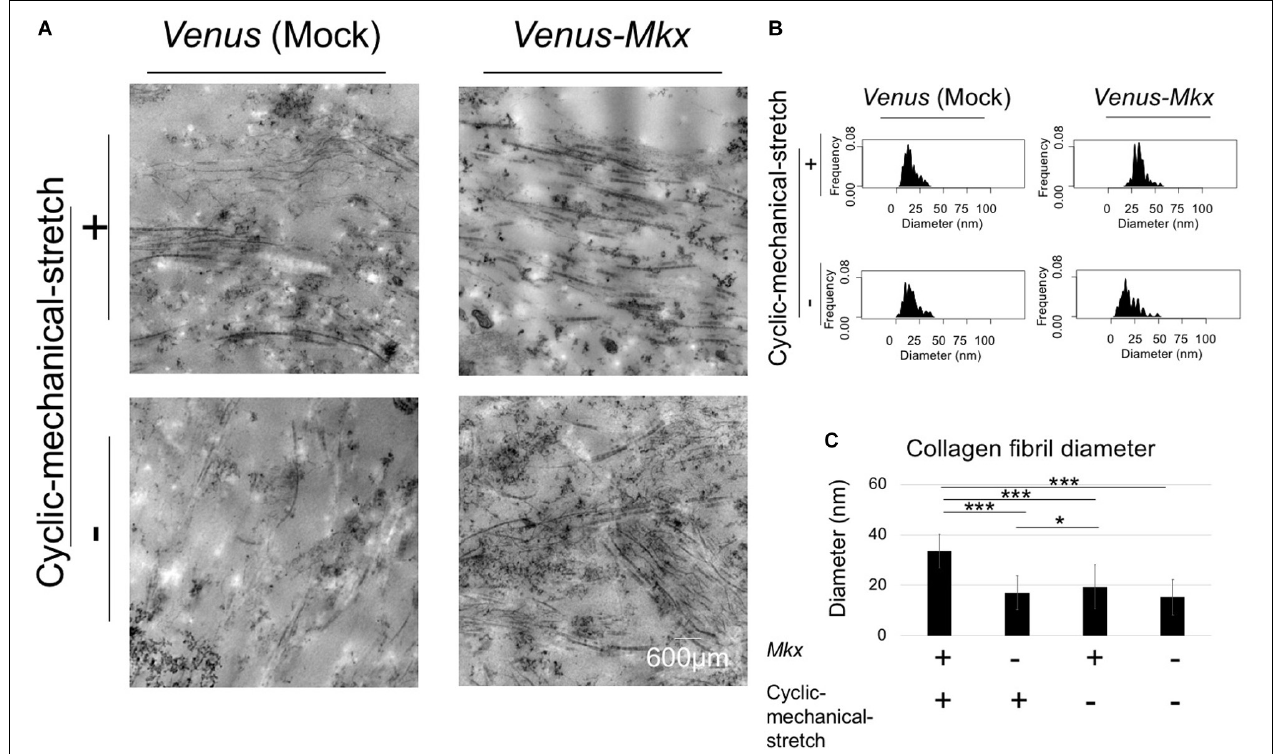
FIGURE 5 | Combination of mechanical stress and Mkx expressing has synergistic effect for thickness of collagen fibril diameter of tendon/ligament-like tissue. (A–C) Analysis of collagen fibril diameter. (A) Vertical section of transmission electron microscopy (TEM) images of tendon/ligament-like tissue. These tissues were generated under four different culture conditions: VMS + (right top), VMS– (right bottom), VS + (left top), and VS– (left bottom) ( n = 3). Scale bar: 600 µ m. (B) Kernel Density Plots of collagen fibril diameters. Data were calculated from 60 collagen fibrils in three different fields of view. (C) Calculated mean collagen fibril diameter from each sample. The mean diameter of 60 collagen fibrils from three different fields of view was calculated: for VMS + condition (right top), mean diameter 34 nm; for VMS– condition (right bottom), mean diameter 19 nm; for VS + condition (left top), mean diameter 17 nm; for VS– condition (left bottom), mean diameter 15 nm. Error bars show the mean ± standard deviation. An asterisk represents the statistical significance calculated by Tukey’s honestly significant difference (HSD) test: * p < 0.05 and *** p <